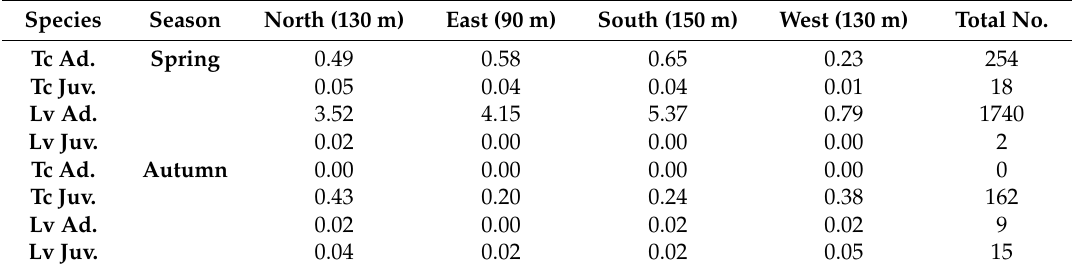
Table 2. Number of adults (Ad.) and juveniles (Juv.) of Great Crested Triturus cristatus (Tc) and Smooth Lissotriton vulgaris (Lv) newts observed per meter on the road around the Lahelldammen pond during spring and autumn for sections North, East, South and West in 2013 (see Figure 1). The lengths of the sections are shown in parentheses, and the total numbers of individuals observed (Total No.) are